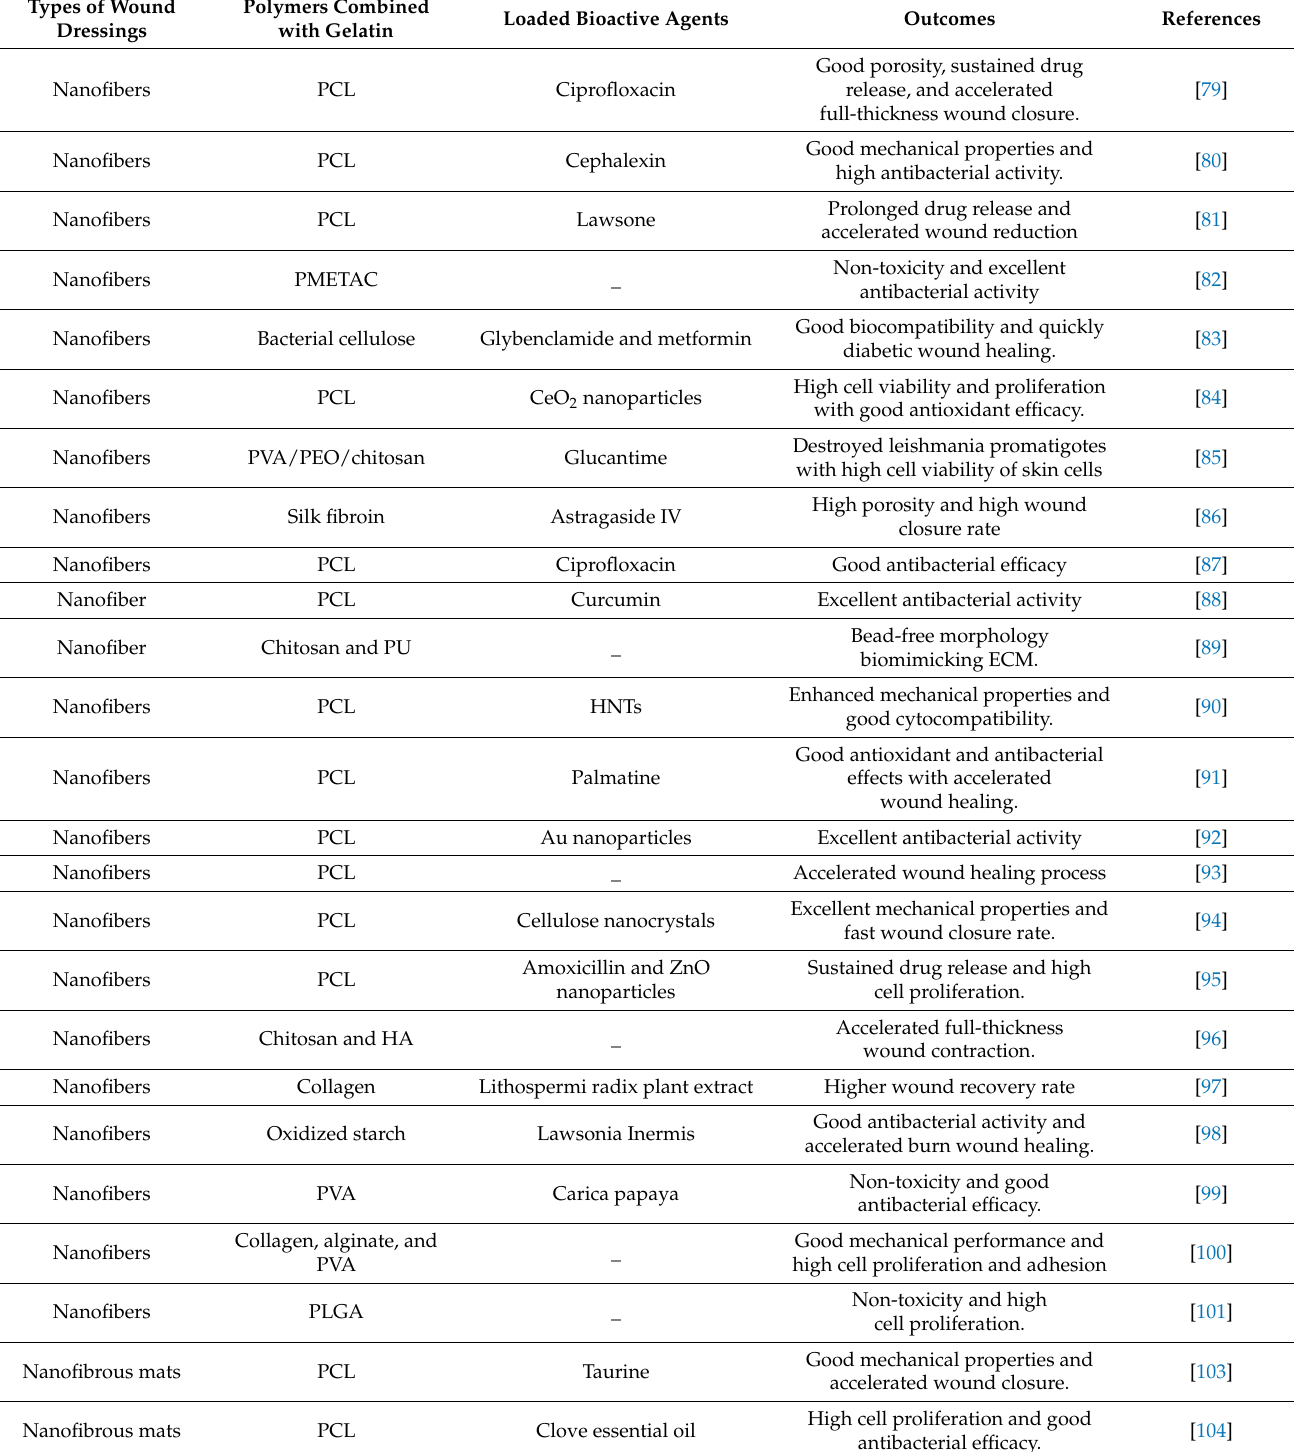
Table 4. Gelatin-based hybrid nanofiber Wound